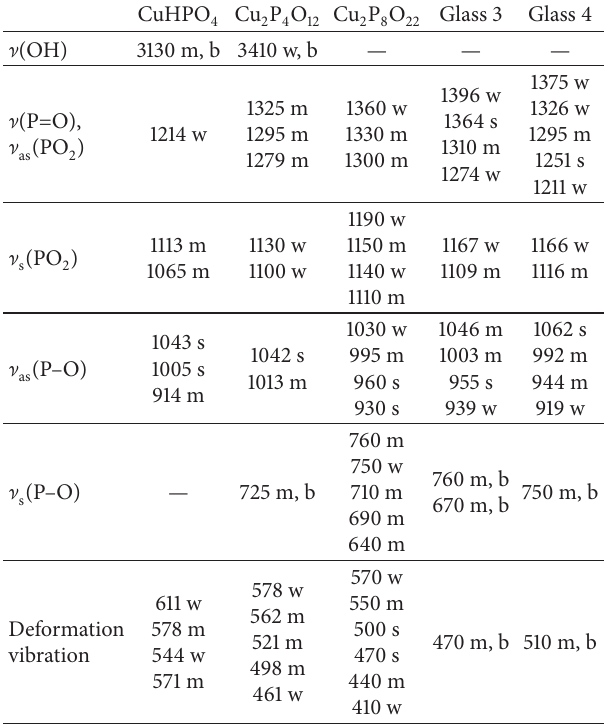
(Cu 2 P 4 O 12 ) crystal structure is built up of Q 2 -bonded rings and the ultraphosphate (Cu 2 P 8 O 22 ) crystal structure of Q 2